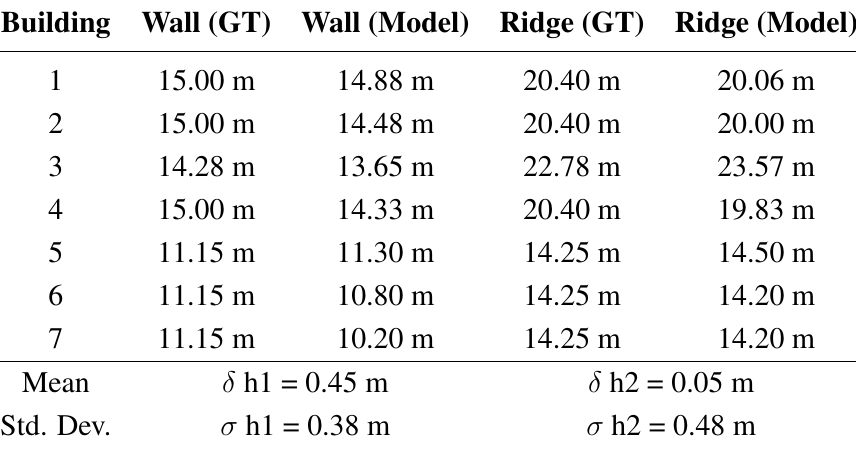
Table 1. Ground Truth (GT) vs . estimated values from 3D